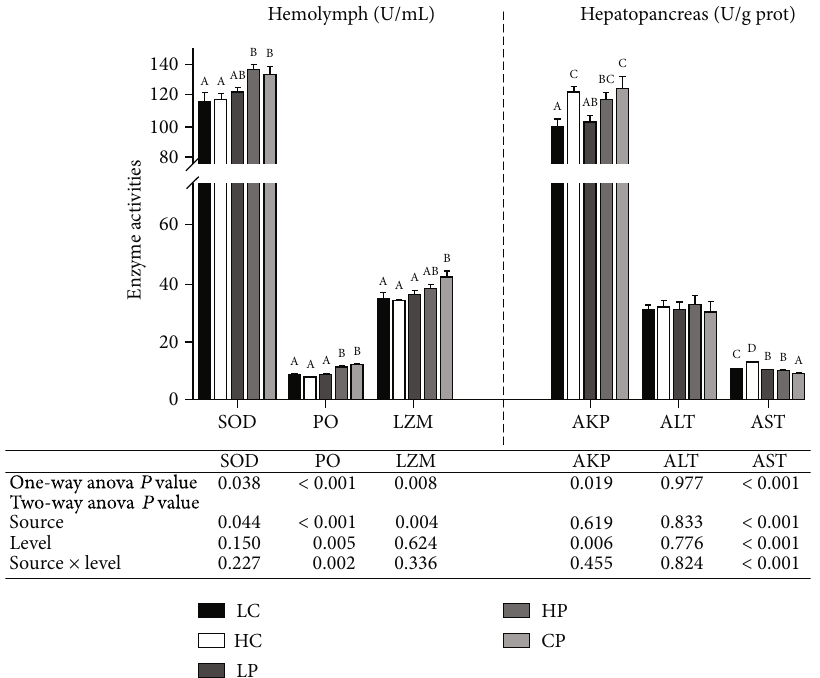
Figure 1: E ff ect of di ff erent sterol sources and levels on nonspeci fi c immunity and health indicators in hemolymph and hepatopancreas of L. vannamei . Vertical bars represent the mean ± SEM ( n = 3 ). Data marked with di ff erent letters di ff er signi fi cantly ( P < 0 : 05 ) among groups based on Duncan ’ s test. The lack of superscript letter indicates no signi fi cant di ff erences among treatments. Two-way ANOVA followed by Student-Newman-Keuls (SNK) multiple comparison test was conducted to investigate the interaction e ff ects of sterol sources and levels. SOD = superoxide dismutase (U/mL); PO = phenol oxidase (U/mL); LZM = lysozyme (U/mL); AKP = alkaline phosphatase (U/g); ALT = alanine transaminase (U/g); AST = aspartate aminotransferase